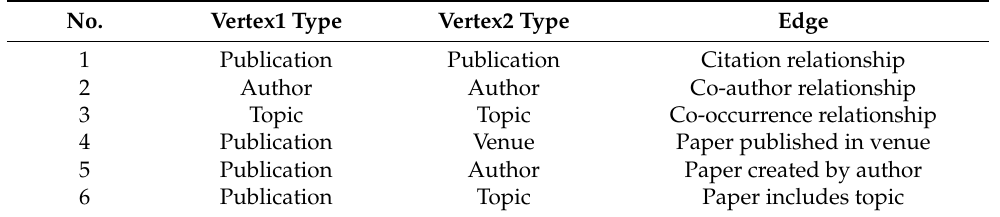
Table 2. Types of vertex and edge.